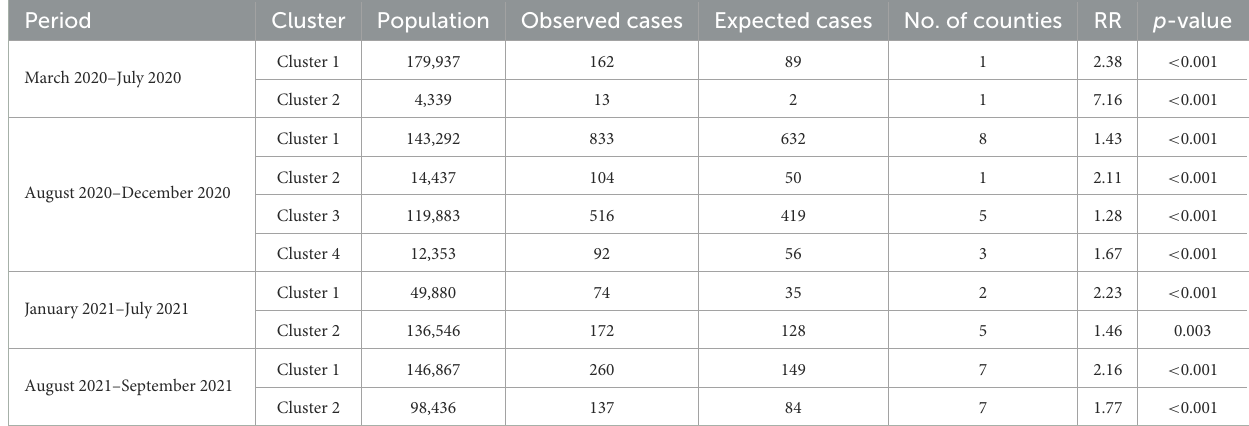
TABLE 2 Spatial clusters of age-adjusted high COVID-19 hospitalization risks identified in North Dakota using Kulldorff’s circular spatial scan statistics, March 2020–September 2021. Period Cluster Population Observed cases Expected cases No. of counties